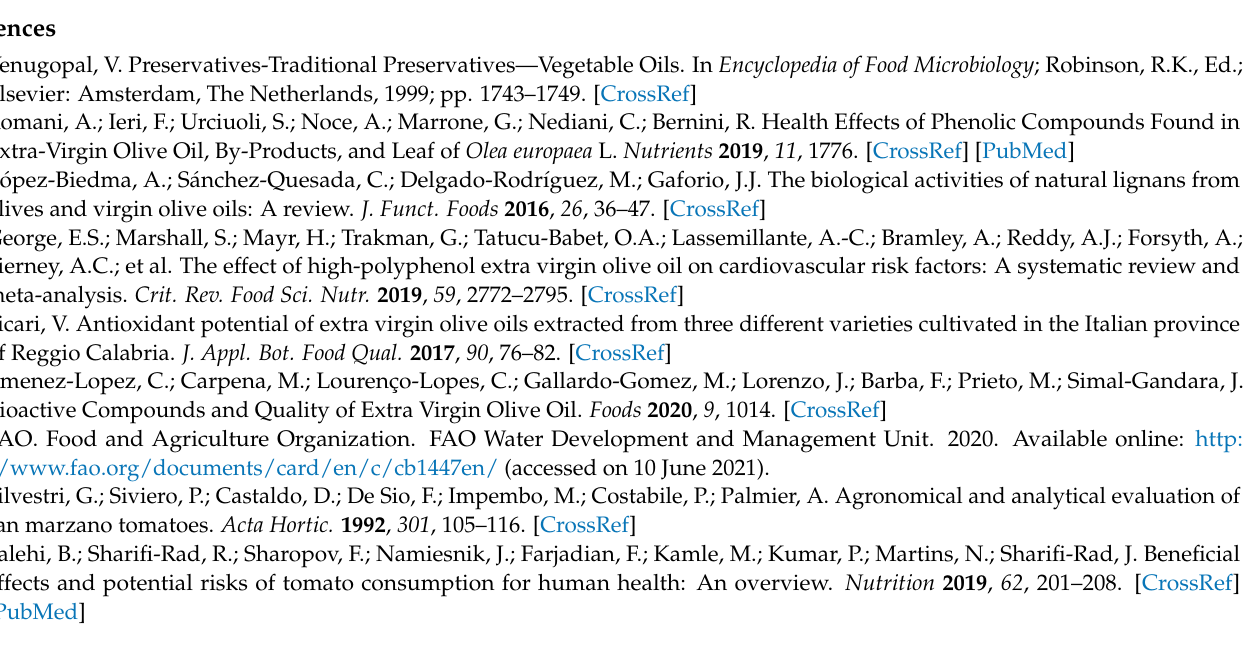
Figure S1: RACI values of EVOO, EVOO_DTL, and EVOO_DTD (a), and dried tomatoes DTD and DTL (b)